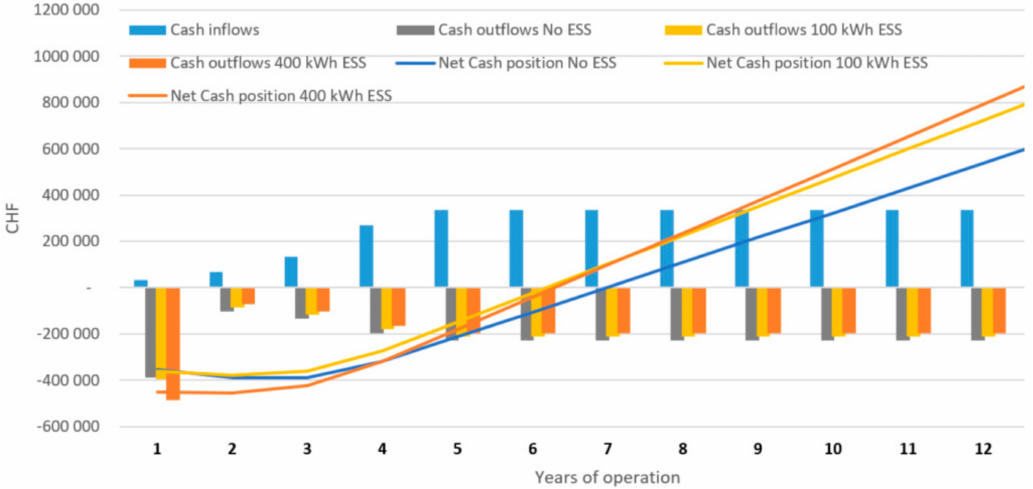
Figure 11. Cash inflows and outflows for a CSO with and without